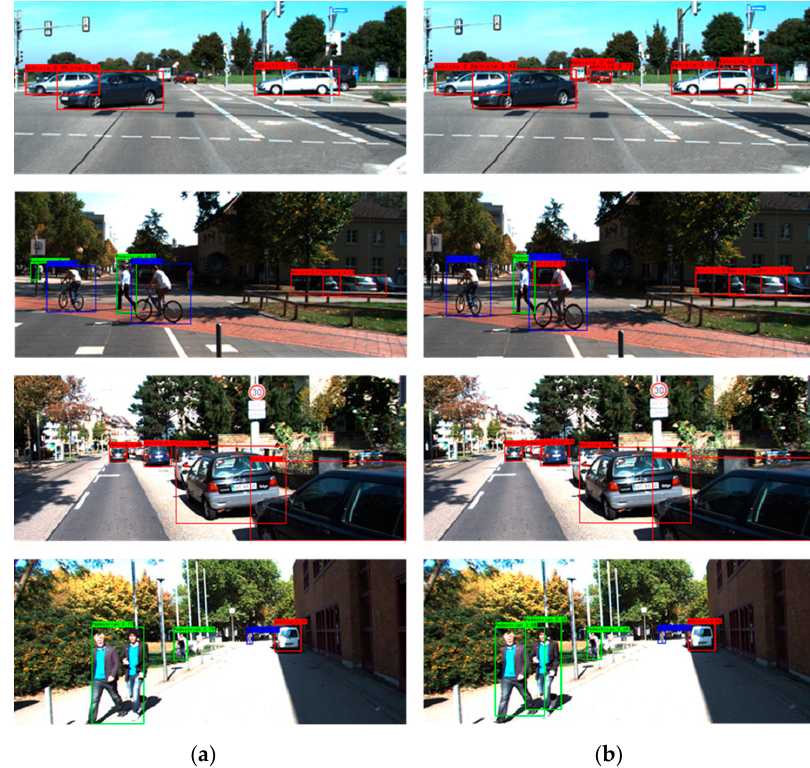
Figure 16. Object detection model inference heat map: ( a ) YOLOv4; ( b )VV-YOLO.